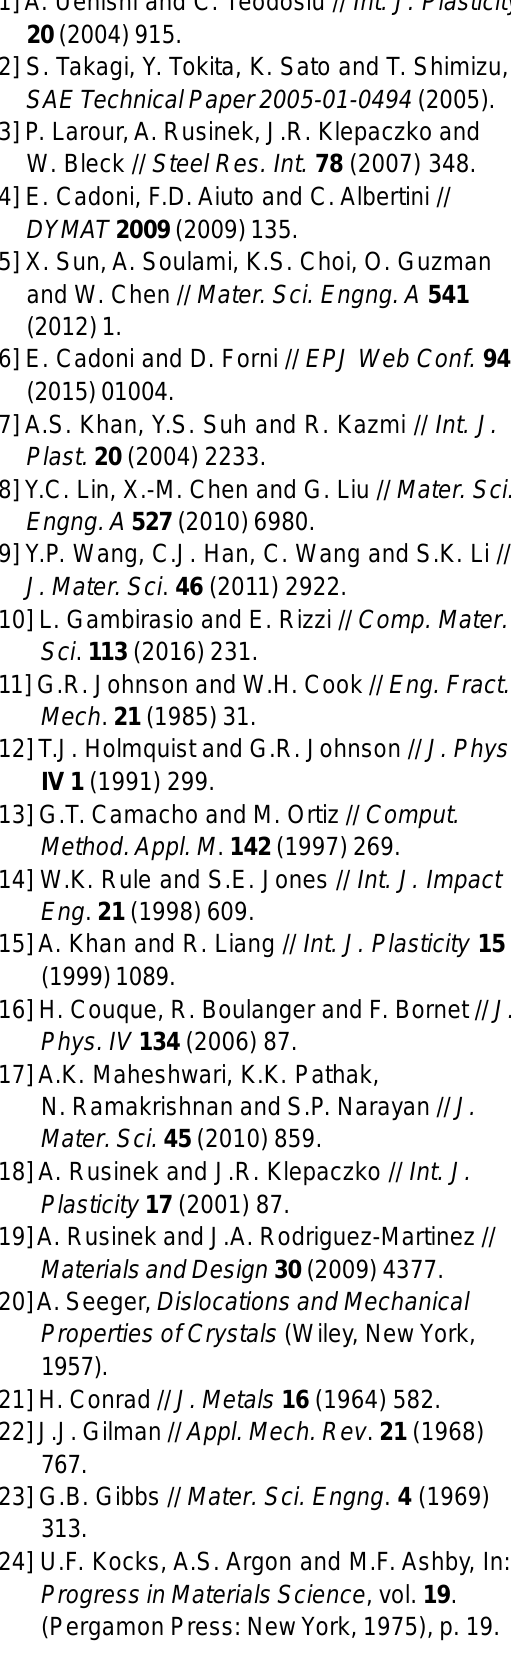
Table 4. Parameters of extended Rusinek- Klepaczko